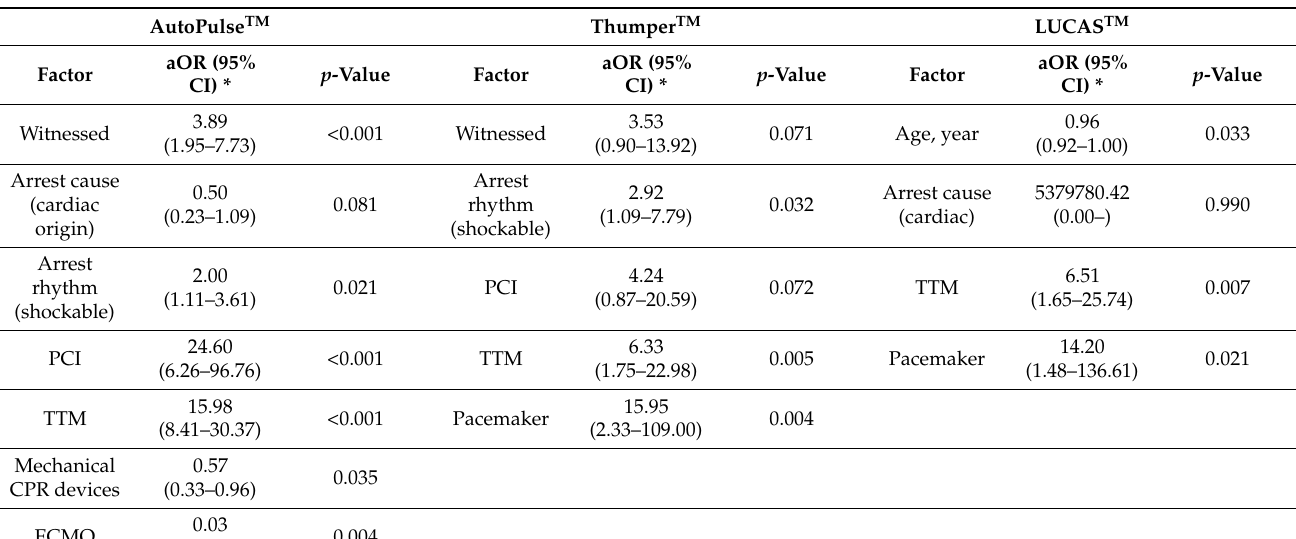
Table 4. Matched multivariate analysis for three types of mechanical CPR device with respect to patient survival at